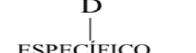
Figure 2. Adapted from Fernanda de Oliveira Cerqueira (2015) 11 .